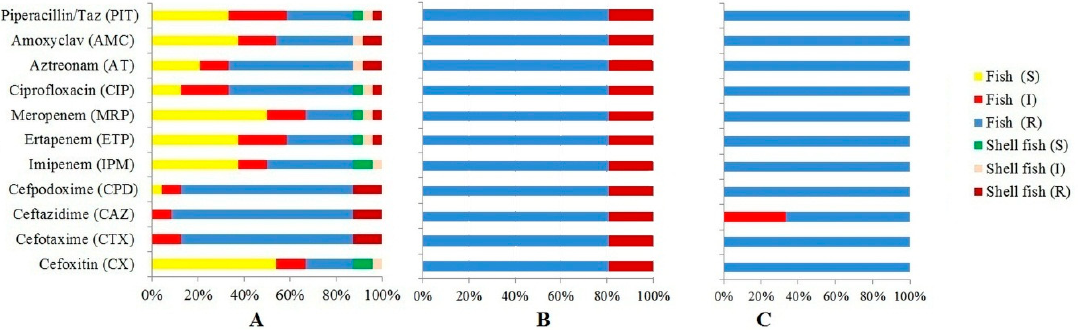
Figure 2. Antibiotic resistance profiles of Escherichia coli isolates harbouring bla OXA (n = 24; fish 21, shellfish 3) ( A ), bla NDM (n = 21, fish 17, shellfish 4 ( B ) and bla VIM (n = 3, fish 3, shellfish 0) ( C ) genes. R = resistant, I = Intermediate resistant and S =